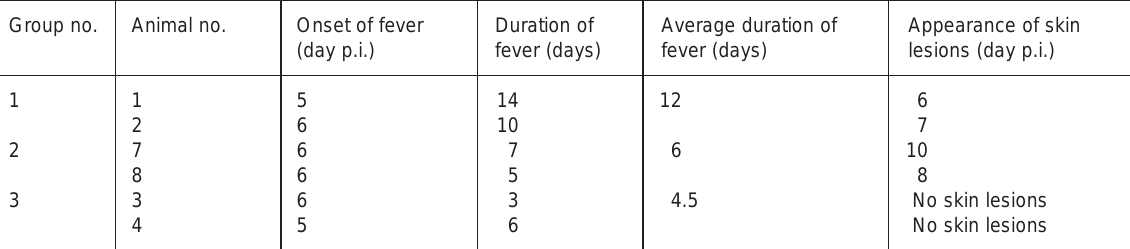
TABLE 3 Temperature reaction relative to the development of skin lesions Group no. Animal